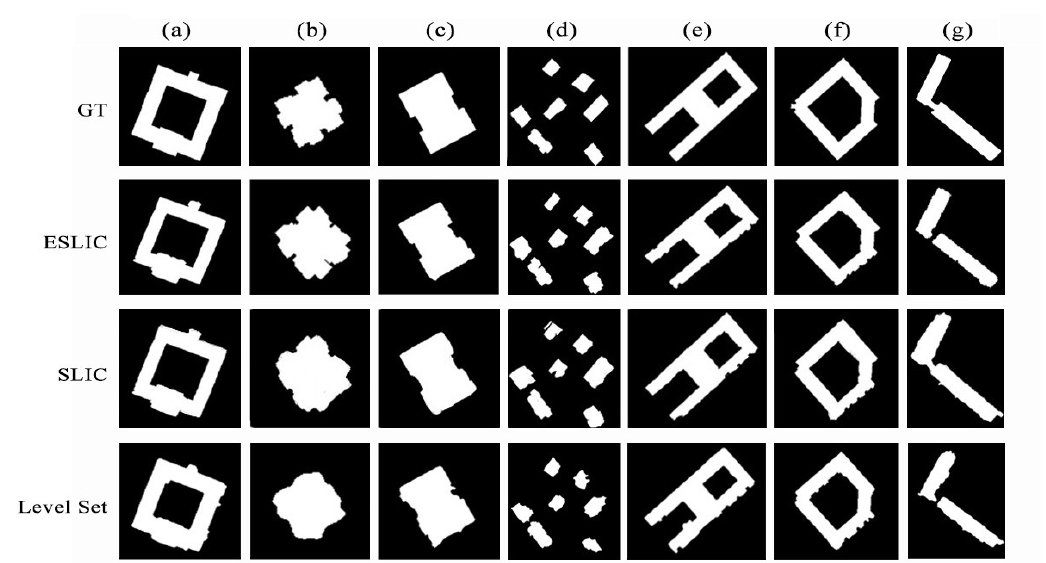
Figure 11. Results of ESLIC in comparison to the ground truth (GT), SLIC and level set results for 7 dataset (a–g) tested in Table 1.